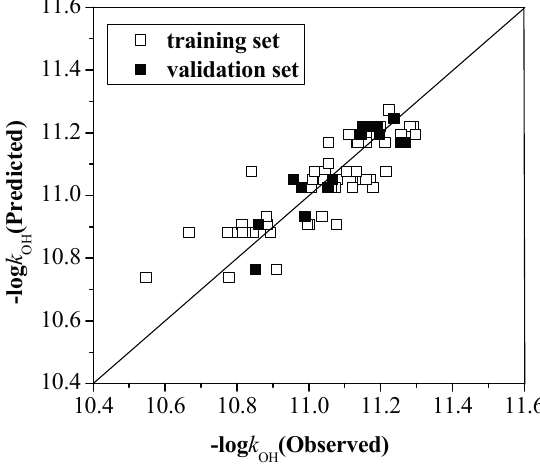
Figure 5. The observed values and predicted values of –log k OH for the training and validation